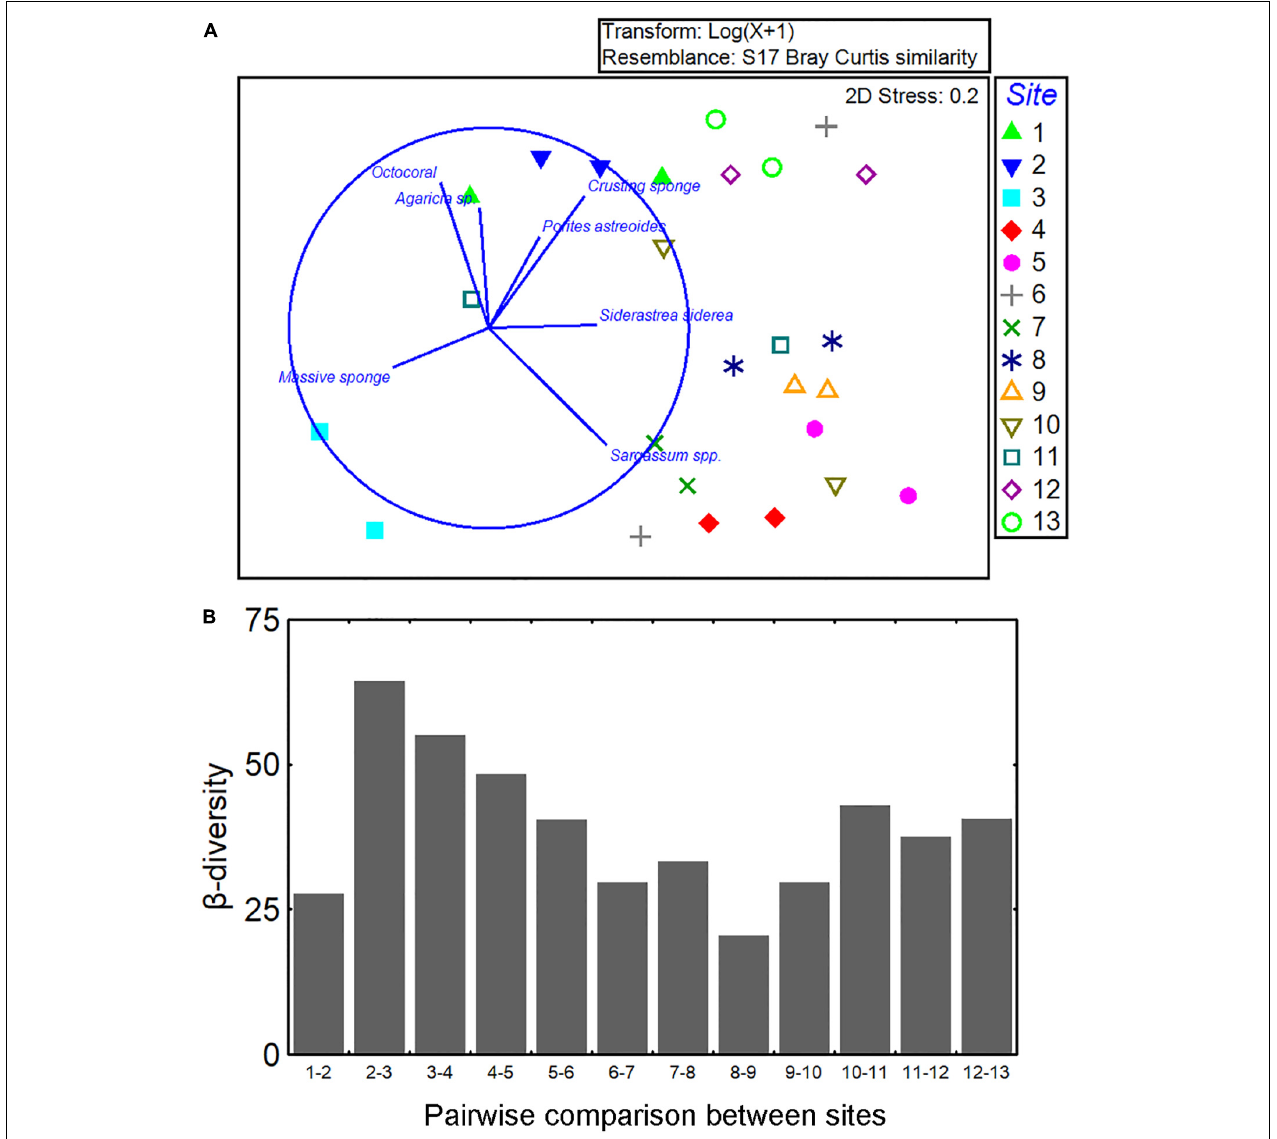
FIGURE 5 | Description of coral species composition across the Jardines de la Reina archipelago. (A) Numerical ordination of the samples by non-metric multidimensional scaling based on transformed [log( x + 1)] data of cover per species/category. Data were averaged by location. Vector plot indicates those species/category having Spearman rank correlation > 0.5 with the ordination configuration, and (B) β -diversity along the reef tract; bars show the pairwise Bray–Curtis dissimilarity index between successive sites (e.g., 1 vs. 2, 2 vs. 3, etc.) in order to focus on the directional change from sites 1 to